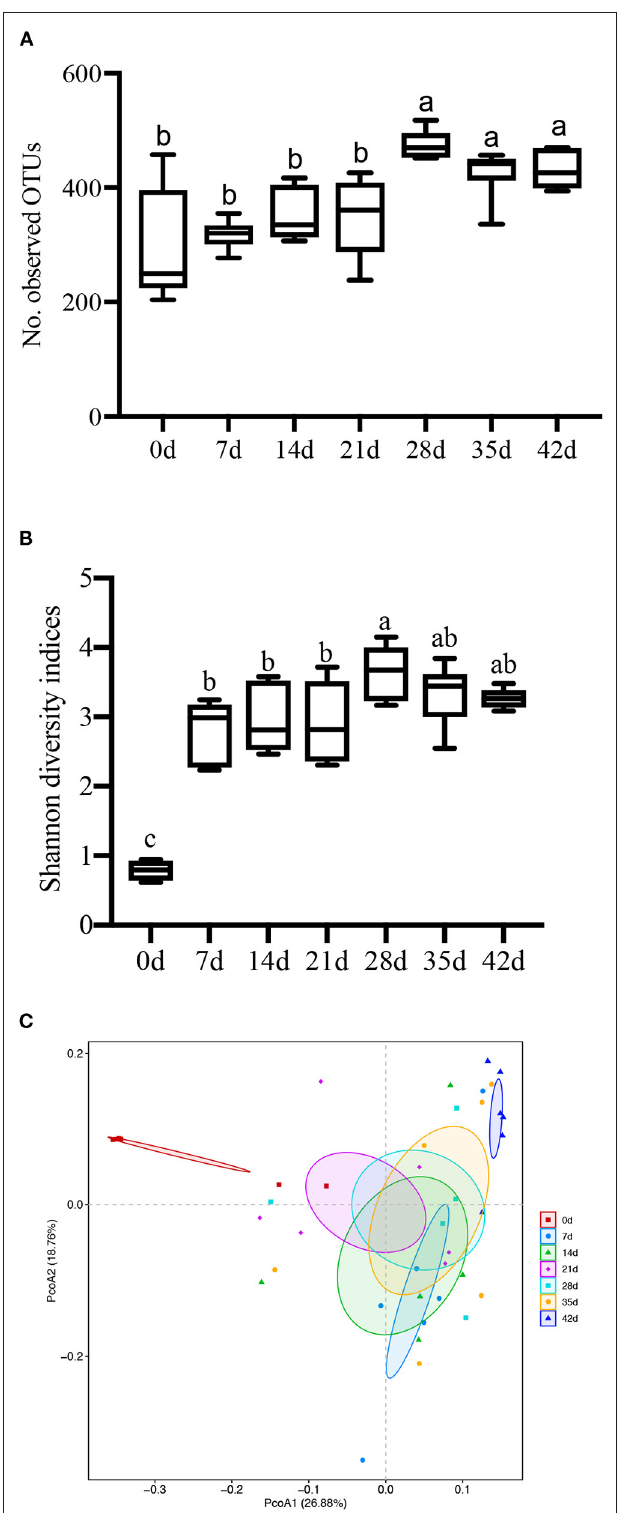
FIGURE 5 | Effect of piglet age on α - and β -diversity of microbial communities in colonic digesta. (A) Bacterial α -diversity determined by no. of observed OTUs. (B) Bacterial α -diversity determined by the Shannon index. (C) Scatter